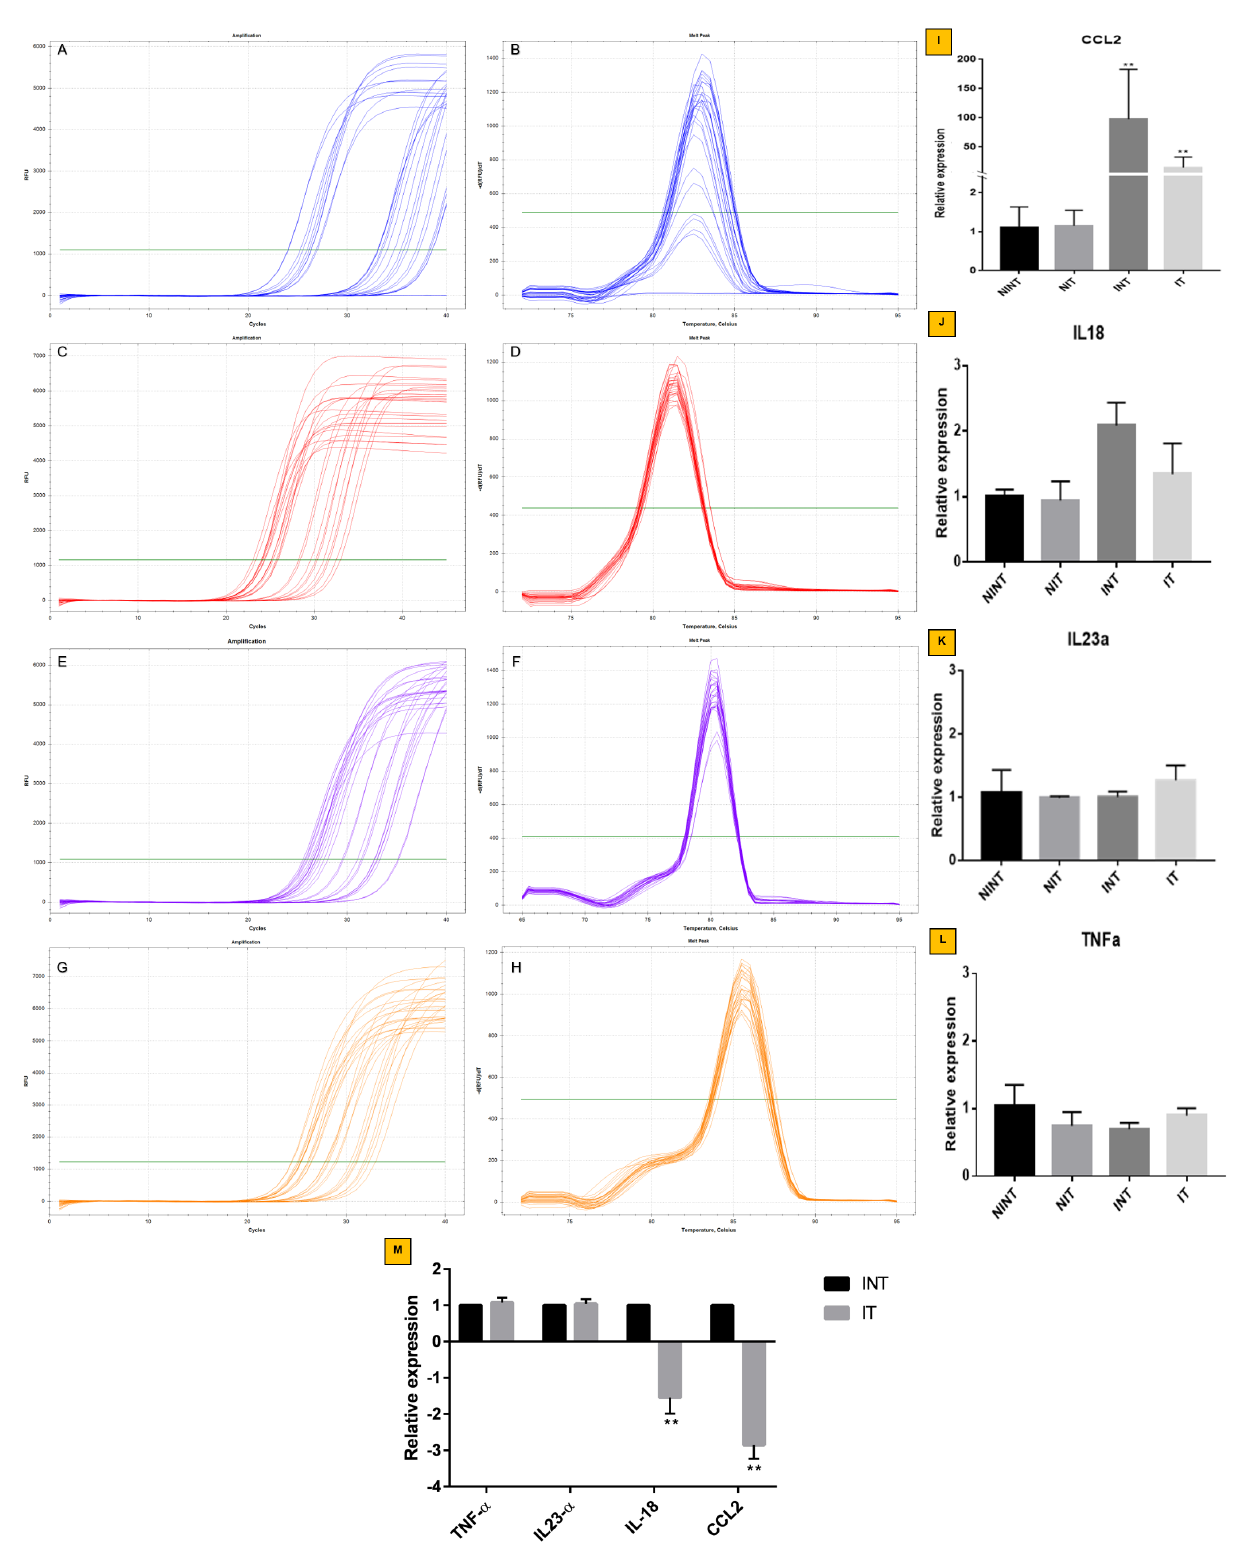
Figure 4. Relative mRNA expression of CCL2, IL-18, IL23 α , and TNF- α in solid breast cancer after ECCT treatment. Amplification and melt peak chart of ( A and B ) CCL2, ( C and D ) IL18, ( E and F ) IL23 α and ( G and H ) TNF- α . Relative expression of ( I ) CCL2, ( J ) IL-18, ( K ) IL23 α and ( L ) TNF- α genes with NINT as a control group. The internal control of relative gene expression is GADPH gene. ( M ) Relative expression of TNF- α , IL23 α , IL-18, and CCL2 INT vs. IT. Error bar shows a standard deviation of three replications;